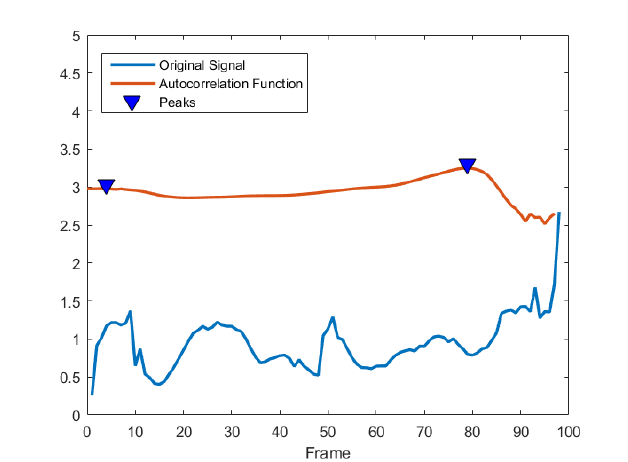
Figure 5. Motion cycle extraction by autocorrelation